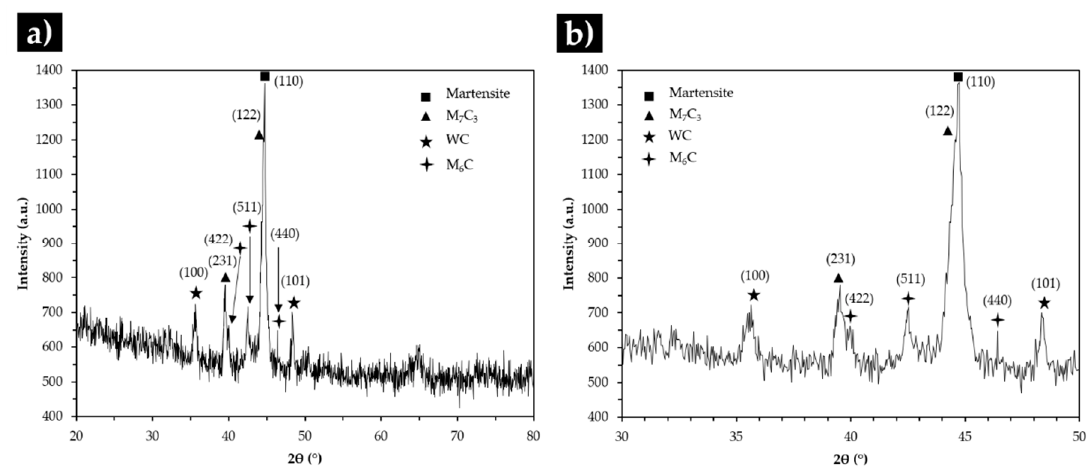
Figure 16. XRD patterns of the composite zone in the 2 θ range of 20°–80° ( a ) and 30°–50° ( b ).